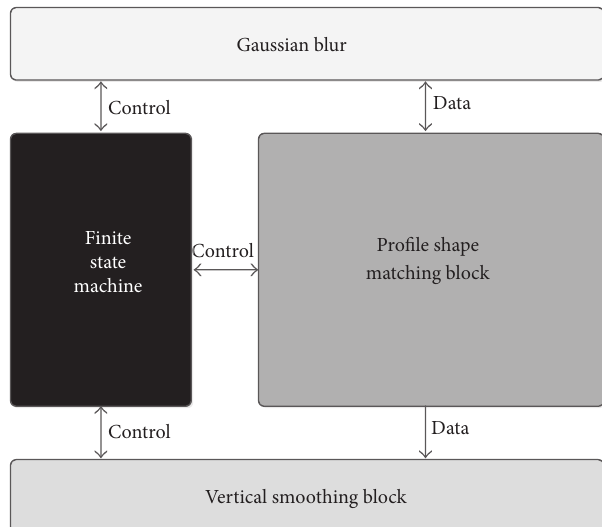
Figure 3: Profile shape matching high-level conceptual hardware block